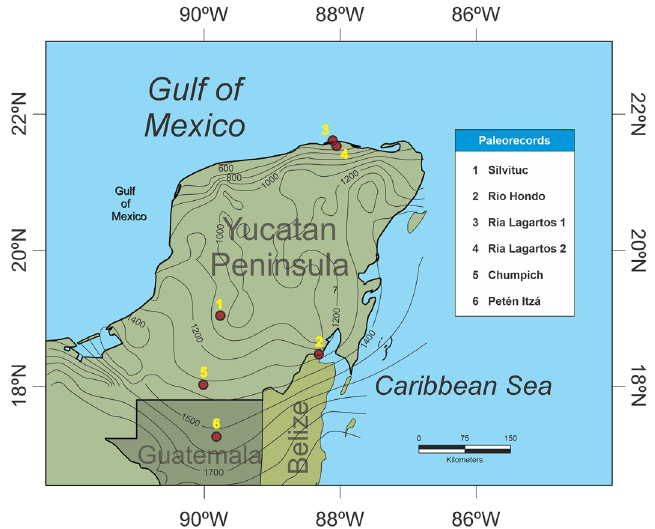
Figure 1. Core locations in the Yucatan Peninsula and Northern Guatemala. Precipitation isohyets showing the present precipitation values. The generated with QGIS versión 3.22.11 58 (https:// qgis. org) and isohyets were drawn based on the precipitation map from INEGI 59